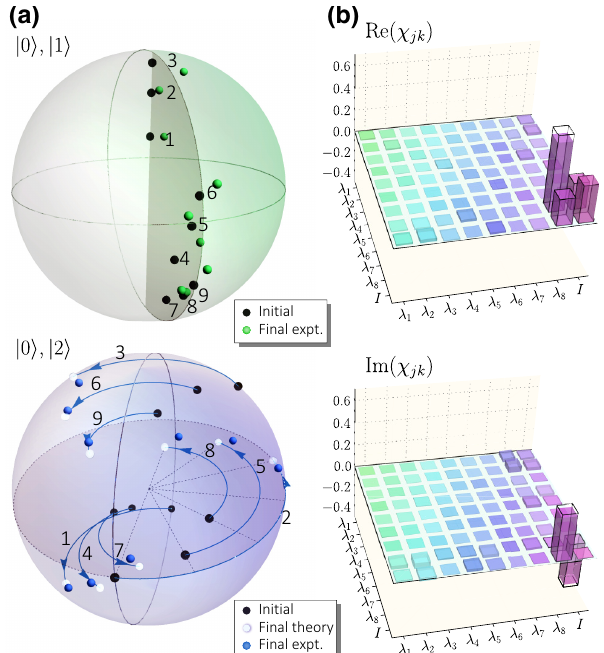
FIG. 3. A demonstration of two-parafermion braiding. (a) We employ nine states | ψ j (cid:2) , j = 1, . . . , 9, to experimentally imple- ment quantum state tomography before and after the braiding process. The top green Bloch sphere shows the {| ψ S | , (cid:6) ψ S |} parts of the density matrix, plotted in green points, {(cid:6) ψ S 0 1 while the bottom blue Bloch sphere indicates the {| ψ S | , (cid:6) ψ S |} parts. The black and white points denote the the- {(cid:6) ψ S 0 2 oretical initial and final states, respectively. In the top subplot, no significant relative phases can be seen, in agreement with the theoretically predicted zero Berry phase between states | 0 (cid:2) and | 1 (cid:2) resulting from parafermion braiding. In the bottom subplot, each pair of points is connected by a circular arc of 2 π/ 3 cen- tral angle, which is the Berry phase induced between | 0 (cid:2) and | 2 (cid:2) by braiding the parafermions. The location of the points is calculated using the expectation values of the Gell-Mann matri- ces { λ 1 , . . . , λ 8 } and the identity matrix, I . (b) The real (top) and imaginary (bottom) parts of the process-matrix elements, χ jk , expressed in the Gell-Mann basis. The edge and filling of the cuboids show the theoretical values and experimental results from quantum process tomography,